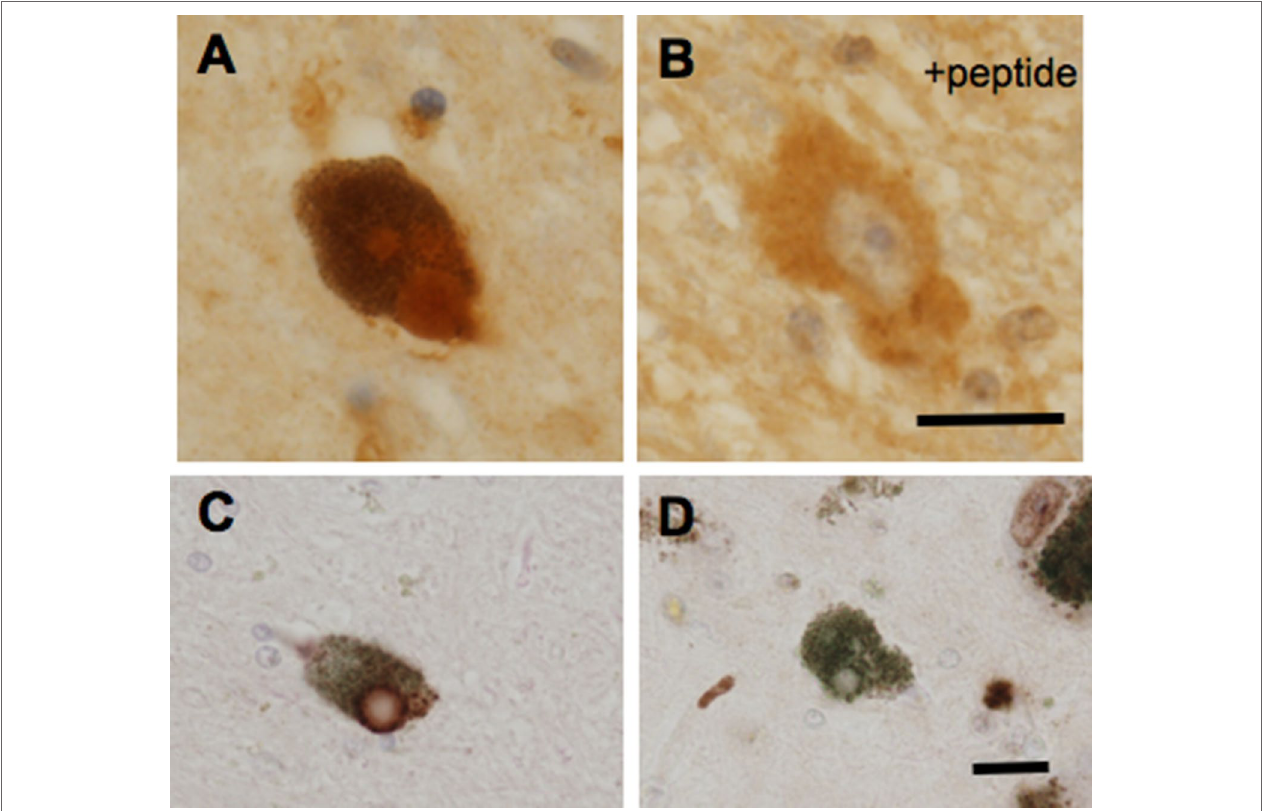
FIGURE 2 | GPR143-positive (A , C) and GPR143–negative (D) Lewy bodies in neurons in the substantia nigra compacta of PD brain tissue. GPR143-positive signals were blocked by the synthetic peptide (B) . Scale bar, 20 μm. (Goshima et al.,